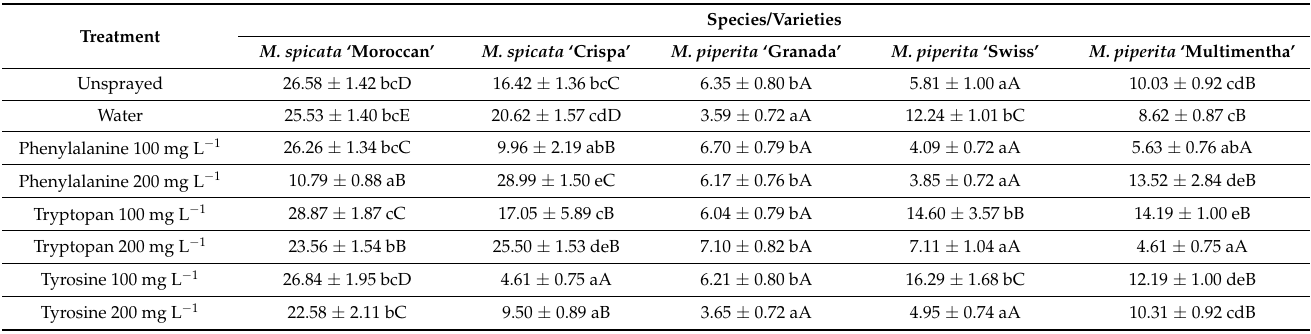
Table 6. Apigenin content in mint influenced by foliar application of amino acids, mg 100 g − 1 DM in